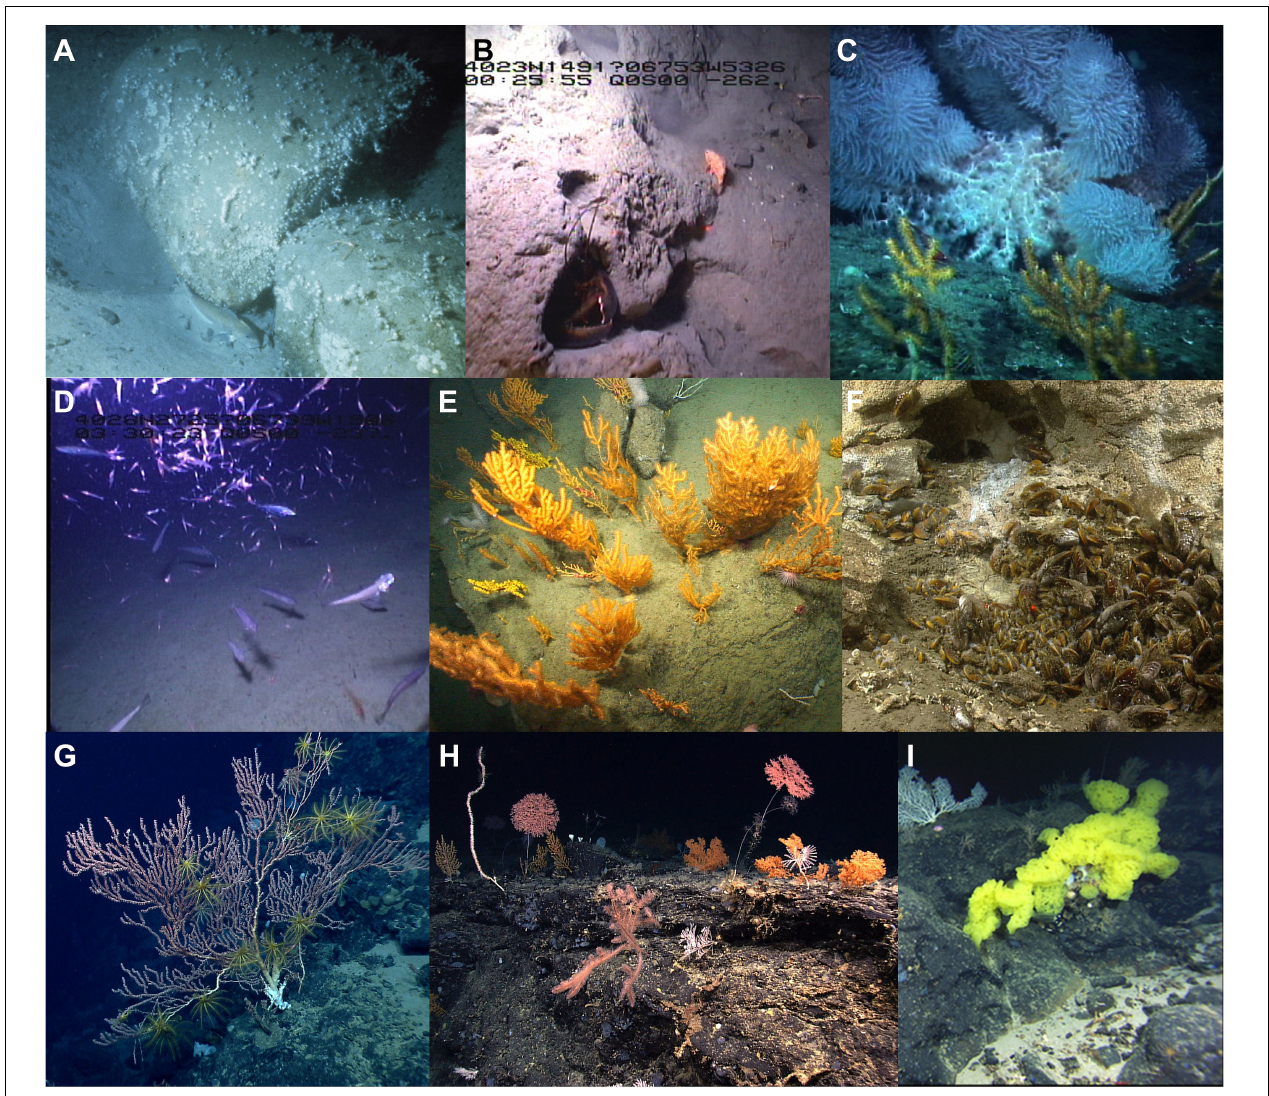
FIGURE 4 | Images of some exemplar communities and habitats. (From top, left to right) (A) Glacier rafted boulders at the head of Oceanographer Canyon. Golden tilefish using crevice for shelter. (B) American lobster burrowed into clay wall at the head of Gilbert Canyon. (C) Octocorals, including a recently described species Thouarella (Euthouarella) grasshoffi (Cairns, 2006) in Oceanographer Canyon. (D) Dense krill and amphipods over seafloor with offshore hake Merluccius albidus preying upon the aggregation in Lydonia Canyon. (E) Dense forest of Paramuricea placomous along outcrop in Oceanographer Canyon. (F) Cold seep with bacterial mat and chemosynthetic mussels (from Nygren Canyon and representative of seeps located with multibeam in Oceanographer and Lydonia Canyons by Skarke et al., 2014). (G) Jasonisis sp. on the flank of Mytilus Seamount. (H) A diverse coral assemblage on a manganese encrusted outcrop on Retriever Seamount, including stony corals, octocorals, precious corals, black corals, and bamboo corals. (I) Dense sponges (Euplectellidae) on Retriever Seamount. [Images (A,B,D) from UConn; (C) DeepEast Expedition NOAA/WHOI/UConn/UMaine; (E–I) Multiple NOAA Ocean Exploration Program expeditions to canyons and seamounts